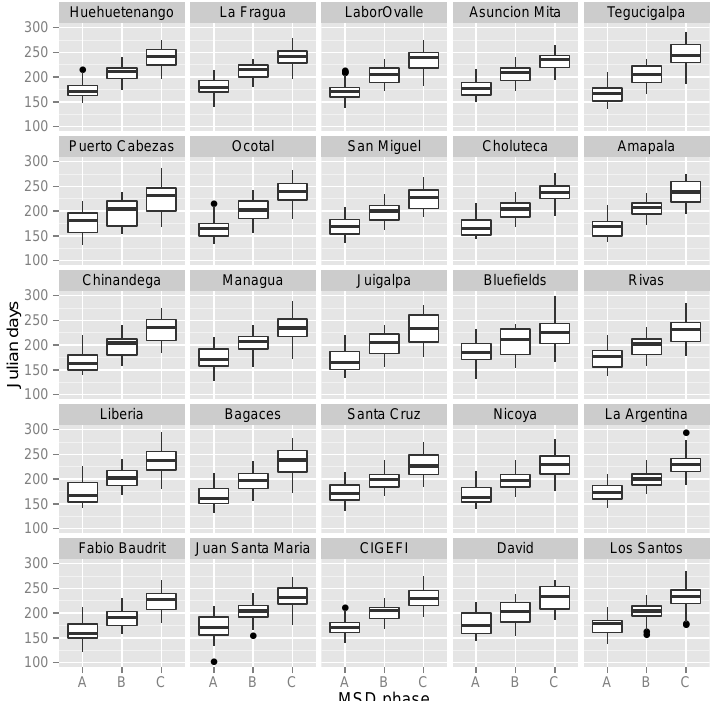
Figure 4. Box-plot of the indexes describing the MSD timing. In the x axis are each of the events defining the MSD, start (A), minimum (B), and end (C). In the y axis are the time-coordinates in Julian days. The upper and lower limits of each box correspond to the first and third quartiles (the 25th and 75th percentiles). The upper (lower) whisker extends from the hinge to the highest (lowest) value that is within 1.5 times inter-quartile range of the hinge. Data beyond the end of the whiskers are outliers and plotted as dots. The median is the bold line in each box. Note that the panels are distributed from north to south, left to right and top to